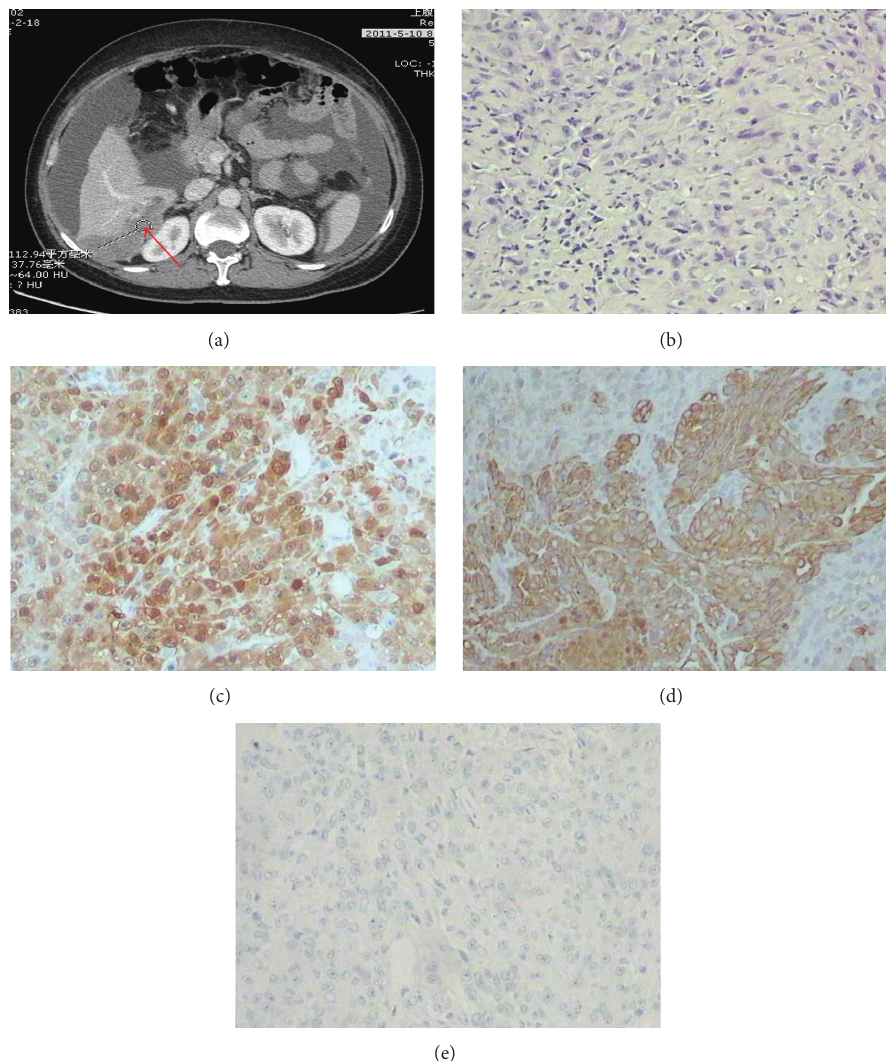
Figure 3: Abdominal CT and cytohistological features on H&E-stained specimens or immunohistochemical stains for case 3. (a) Abdominal CT demonstrated that the greater omentum and peritoneum around the liver were thickened accompanying mass shade, with infiltration of the posterior segment of right liver (red arrows). (b) Cytohistological features of the peritoneum biopsy on H&E-stained specimens. Immunohistochemical stains showed that the tumour cells were positive for calretinin (c) and cytokeratin (d) but negative for carcinoembryonic antigen